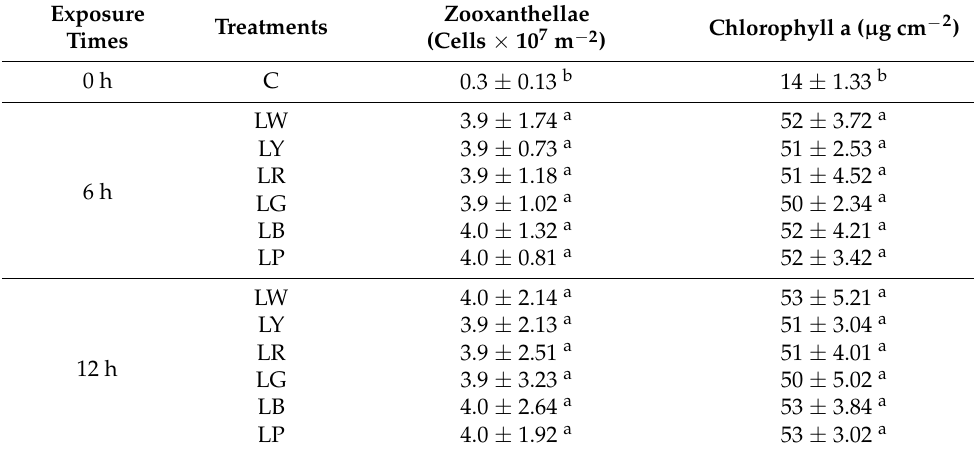
Table 6. Zooxanthellae density and chlorophyll a concentration in G. columna after 8 weeks of daily exposure to different light sources for 6 or 12